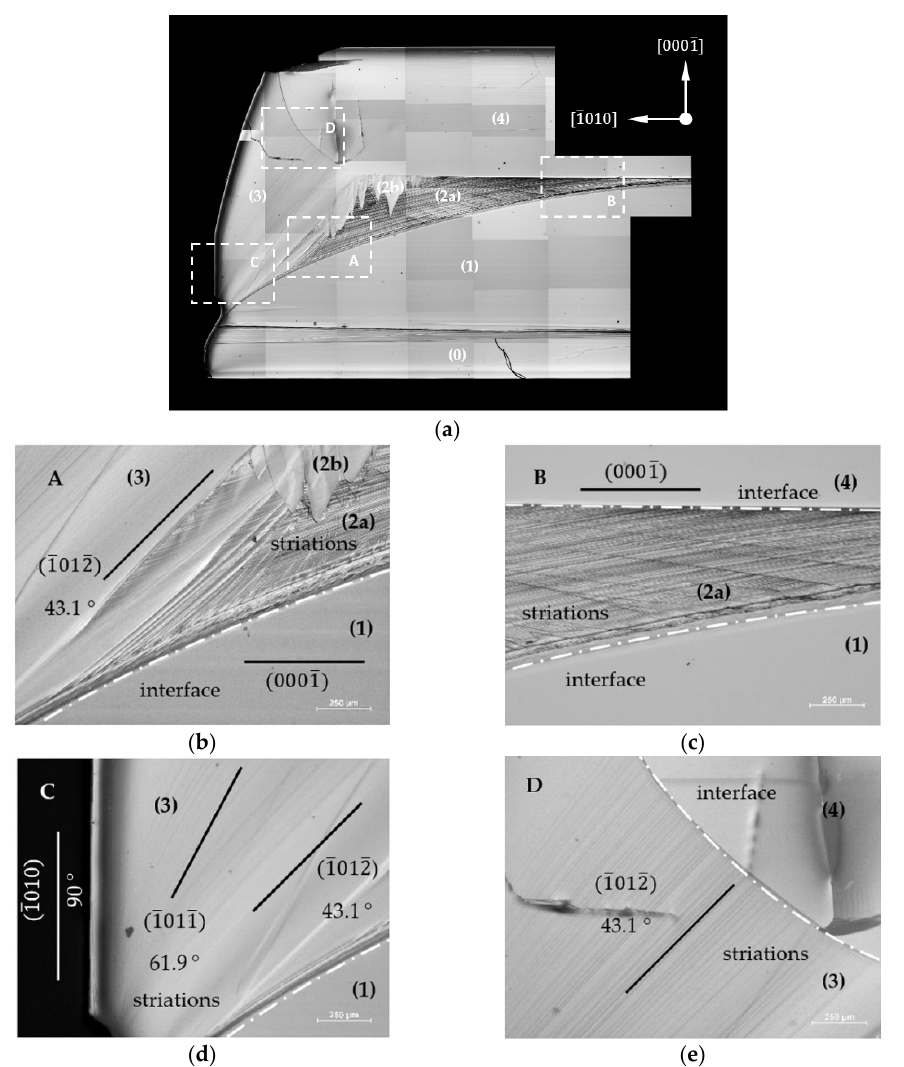
Figure 4. Images of the (12(cid:3364)10) slice of an Am-GaN crystal after the PE: ( a ) View of the entire sample; white rectangles (A–D) indicate the sectors chosen for further detailed analysis. ( b ) Sector A; ( c ) sector B; ( d ) sector C; ( e ) sector D. Crystallographic planes parallel to the visible striations and their angle of inclination to the (0001(cid:3364)) plane are marked: the (1(cid:3364)012(cid:3364)) plane and 43.1°, the (1(cid:3364)011(cid:3364)) plane and 61.9°, and the (1(cid:3364)010) plane and 90°; interfaces between different areas of the crystal (see a ) are marked with white dashed lines.